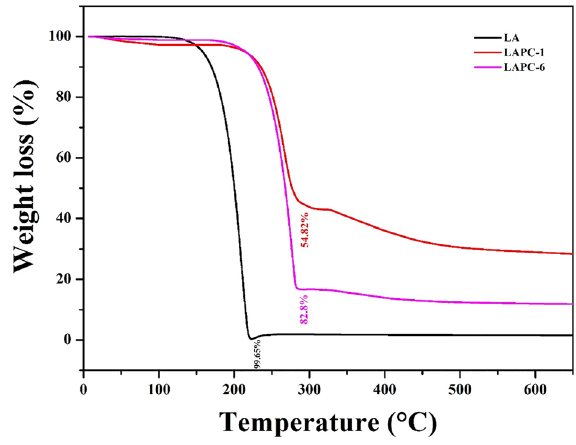
Figure 12. TGA curves of bulk LA and microencapsulated